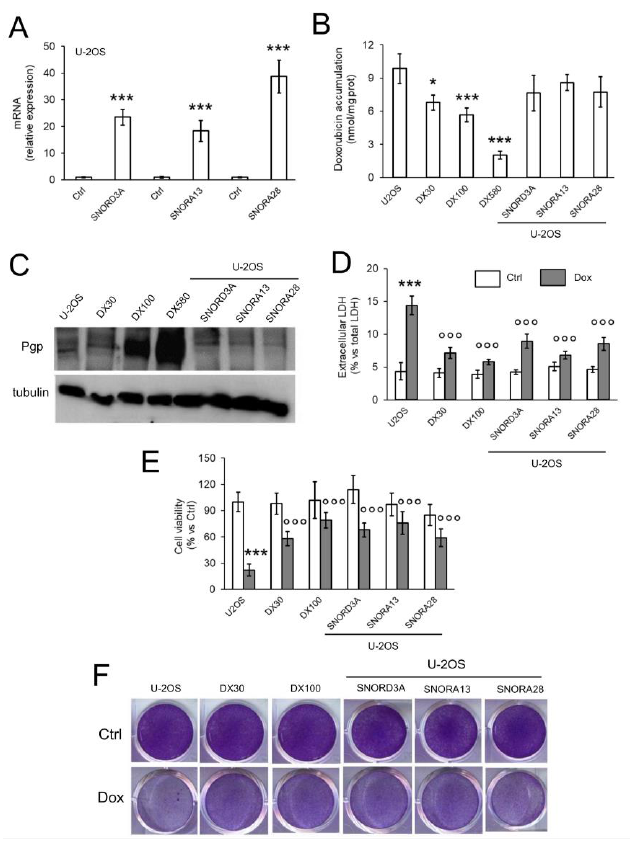
Figure 3. SNORD3A , SNORA13 and SNORA28 induce resistance to doxorubicin in sensitive osteosarcoma cells. U-2OS cells were transfected with empty vector (Ctrl) or expression vectors for SNORD3A , SNORA13 and SNORA28 . When indicated, cells were treated with 5 μM Dox for 3 h (panel B ), 24 h (panel D ), 72 h (panels E , F ). U-2OS/DX30, U-2OS/DX100 and U-2OS/DX580 cells were used as control of Dox-resistant cells. ( A ) mRNA levels of SNORD3A , SNORA13 and SNORA28 , evaluated by RT-PCR, in triplicates. Data are means + SD ( n = 3). *** p < 0.001: snoRNA-over-expressing U-2OS cells vs. Ctrl cells. ( B ) Intracellular doxorubicin accumulation, measured fluorometrically, in duplicates. Data are means ± SD ( n = 3). * p < 0.05, *** p < 0.001: snoRNA-over-expressing U-2OS cells vs. Ctrl cells. ( C ) Pgp immunoblot. The figure is representative of one out of three experiments. measured spectrophotometrically, in duplicates. Data are means + SD ( n = 3). *** p < 0.001: Dox-treated U-2OS cells vs. Ctrl cells; ◦◦◦ p < 0.001: U-2OS / DX30, U-2OS / DX100 or snoRNA-over-expressing